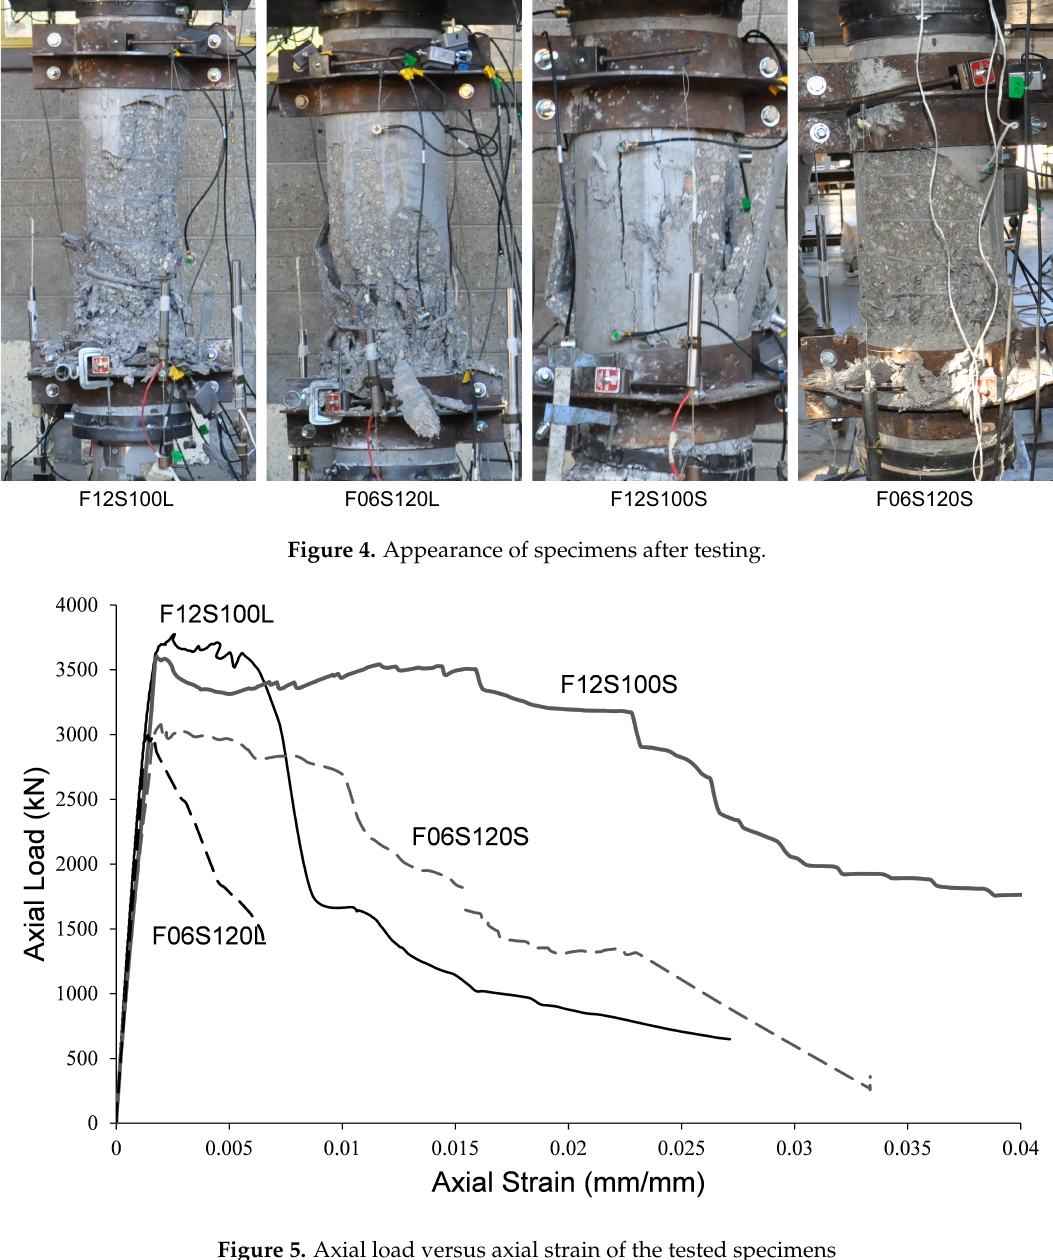
Figure 5. Axial load versus axial strain of the tested